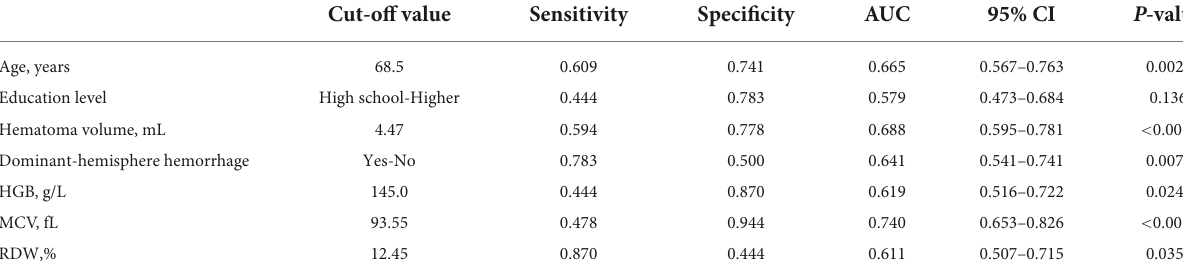
TABLE 4 Performance of each prognostic factor of PSCI in ICH patients.